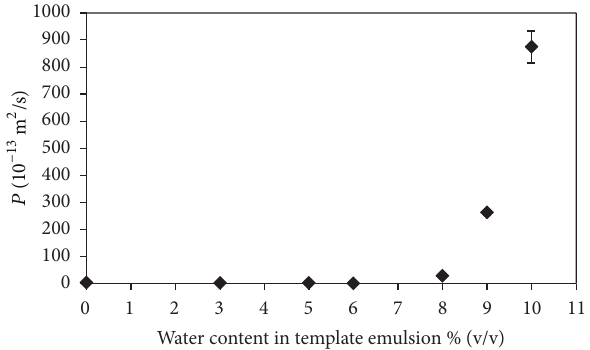
Figure 7: Plot of the water permeability for films casted from template emulsions with 10% of water and increasing Li 2 SO 4 content in the water phase. The permeability was normalized against the film thickness. Error bars indicate min/max deviation ( 𝑛 = 2